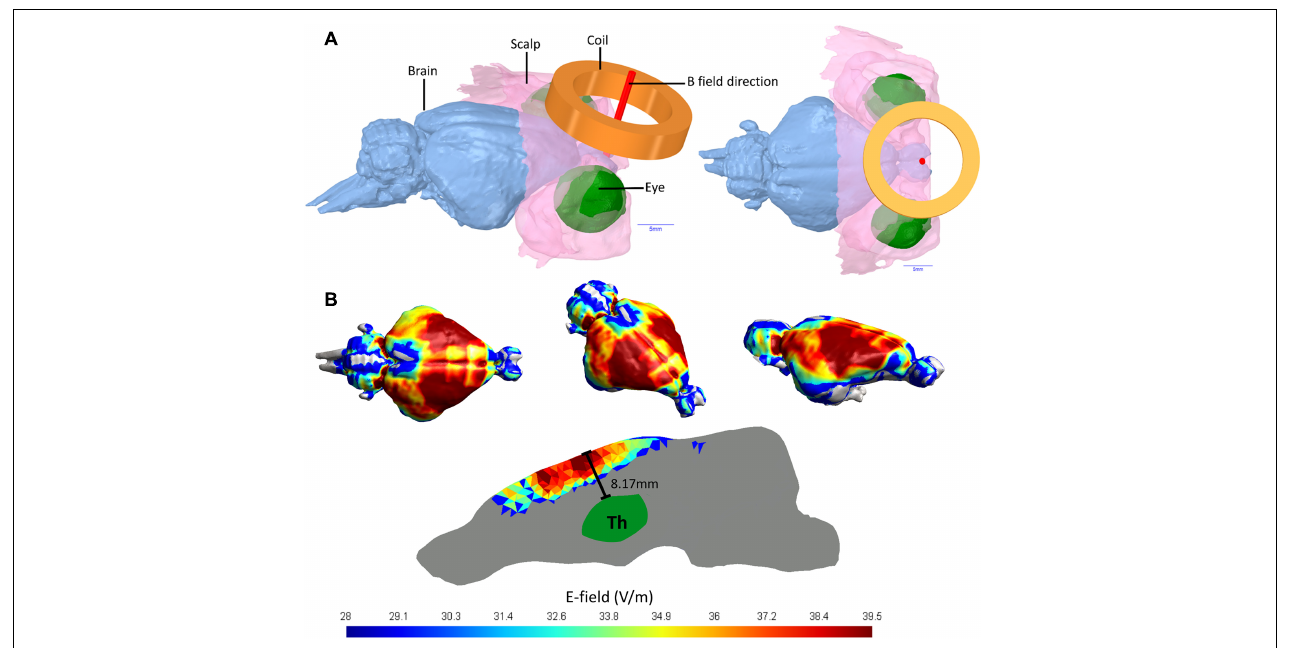
FIGURE 1 | Guinea pig head 3D model and E-fields in guinea pig brain. (A) MRI imaging of a Guinea pig head utilized to produce a 3D head model showing the brain, the coil position held 2 mm from the scalp and the E-field direction of the active coil pointing directly into the brain. (B) The E-fields in V/m for simulated TMS stimulation of a guinea pig brain using a MagVenture Cool-40 Rat coil at 23% of maximum stimulator